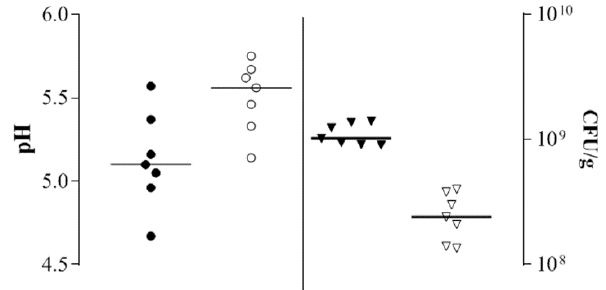
Figure 3. Scatterplot of the final pH and cell concentrations of the doughs with NaCl addition (black symbols) and without NaCl addition (white symbols), inoculated with the 7 strains after 8 h of fermentation at 30 °C. pH values are represented by circles plotted on the left axis; bacterial cell densities are represented by triangles plotted on the right side. Horizontal bars represent the median values.